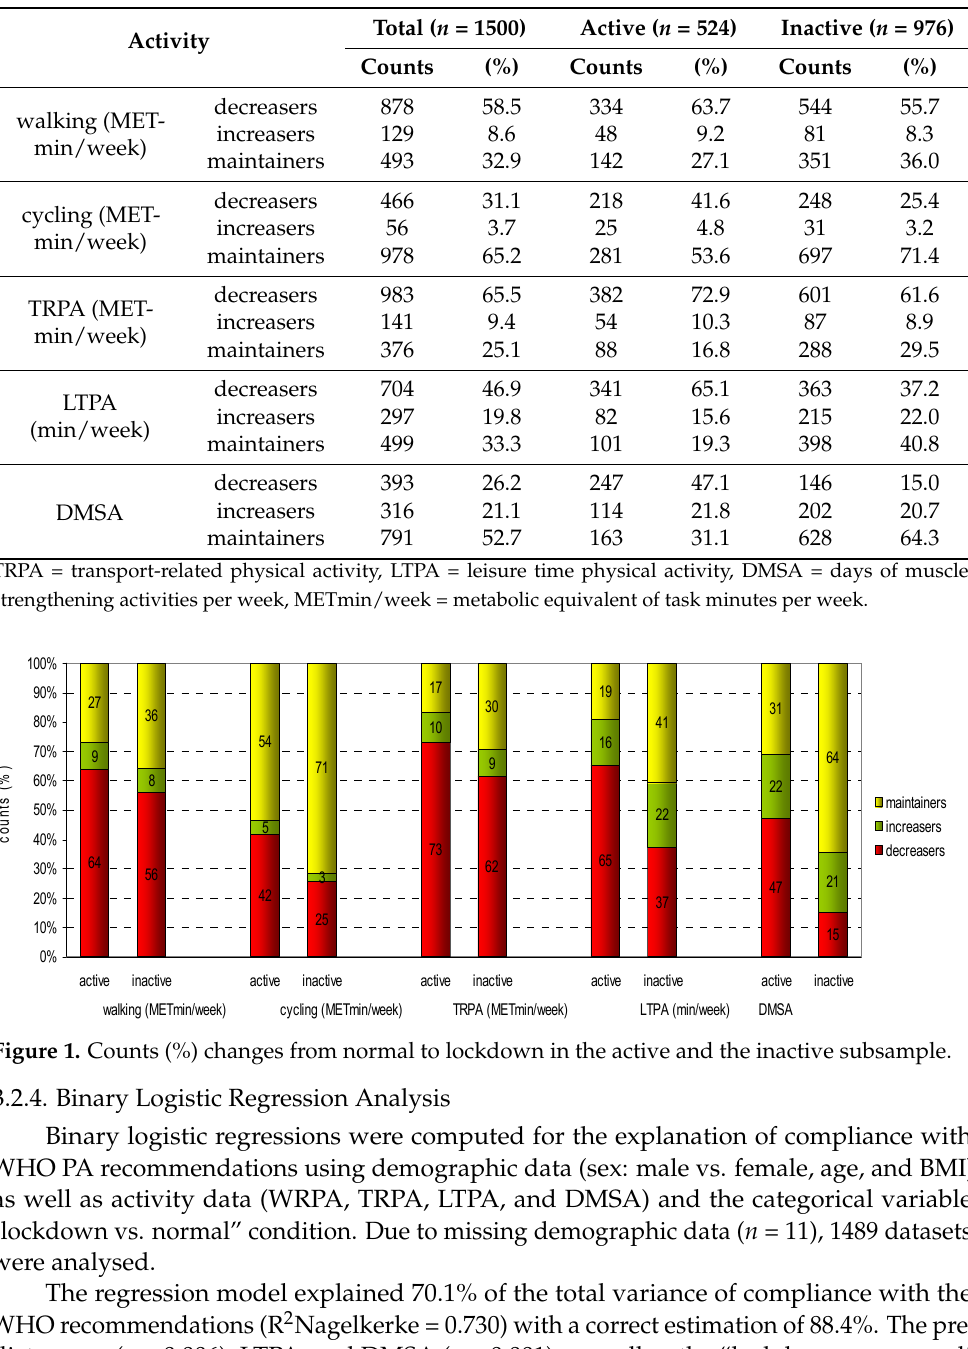
Table 8. Counts (%) changes from normal to lockdown in the total, the active and the inactive subsample. Activity